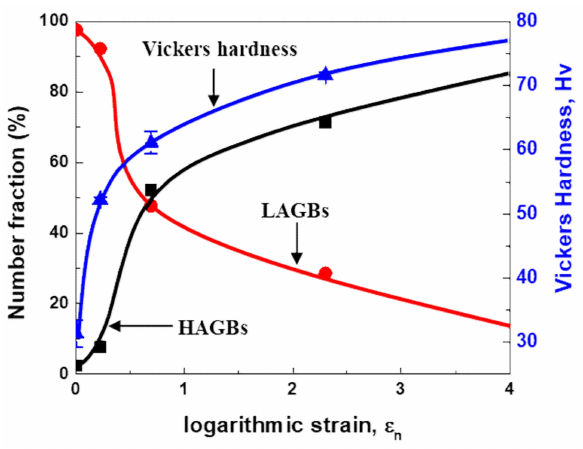
Figure 7. Changes in the number fraction of the LAGBs and HAGBs, and Vickers hardness with increase of the amount of reduction in the AA3003